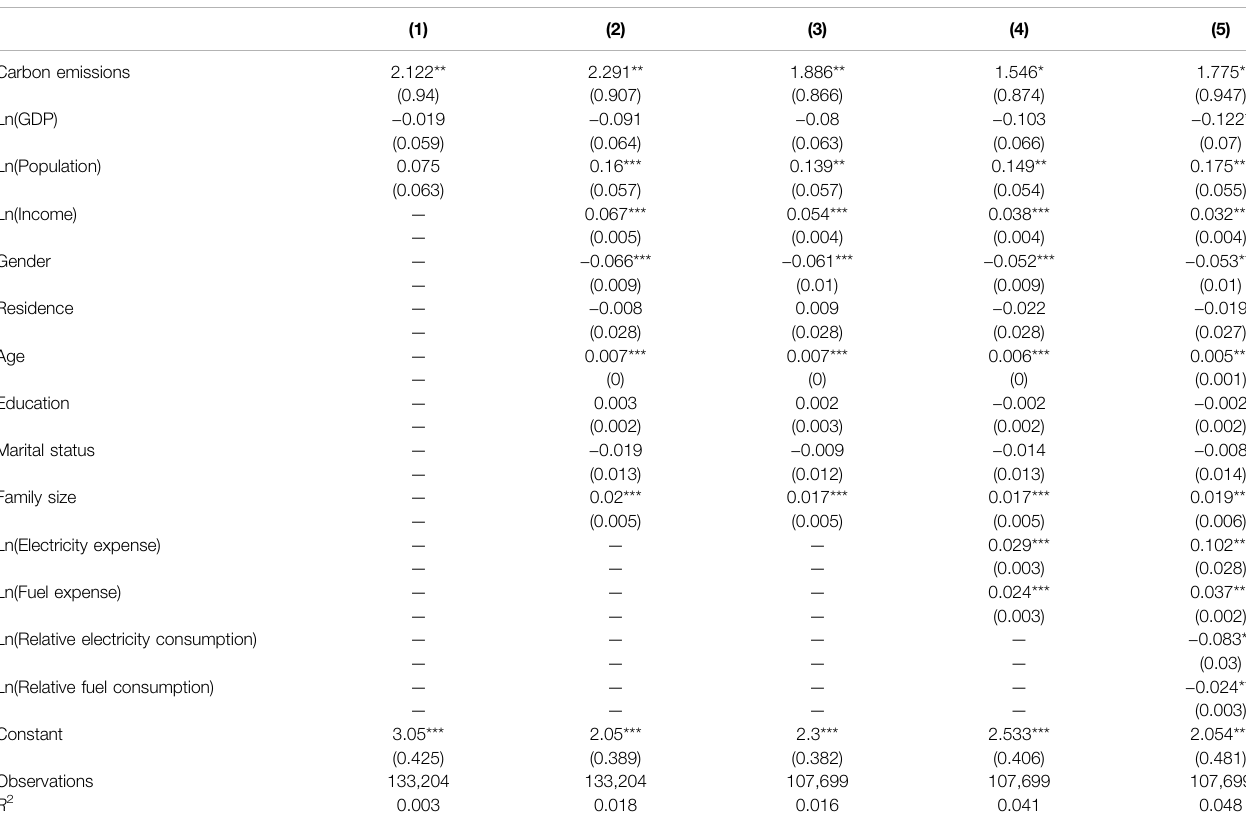
TABLE 2 | The impact of carbon emissions and energy consumption on Life